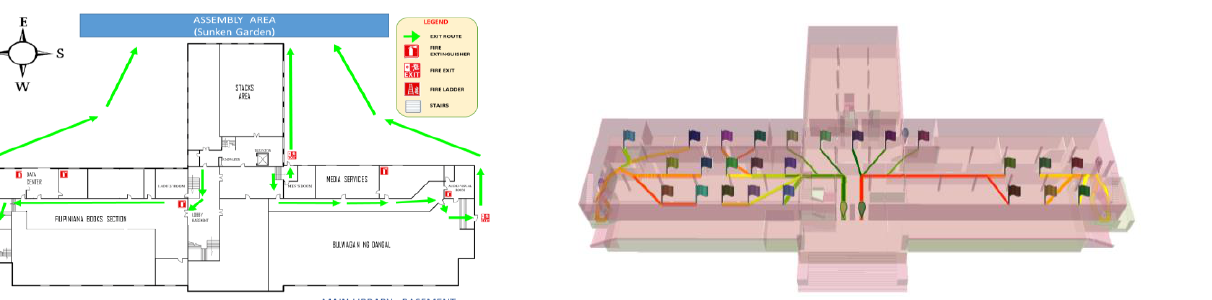
Figure 10. Currently Implemented Evacuation Basement Routes